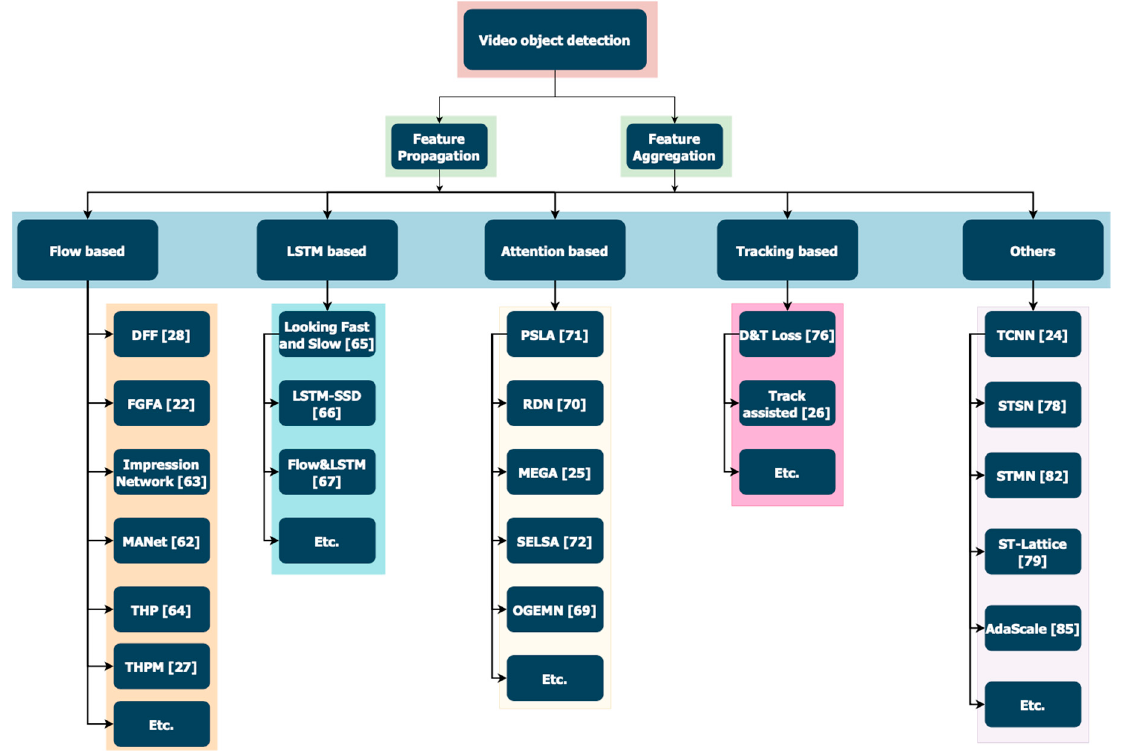
Figure 2. Categories of video object detection methods.